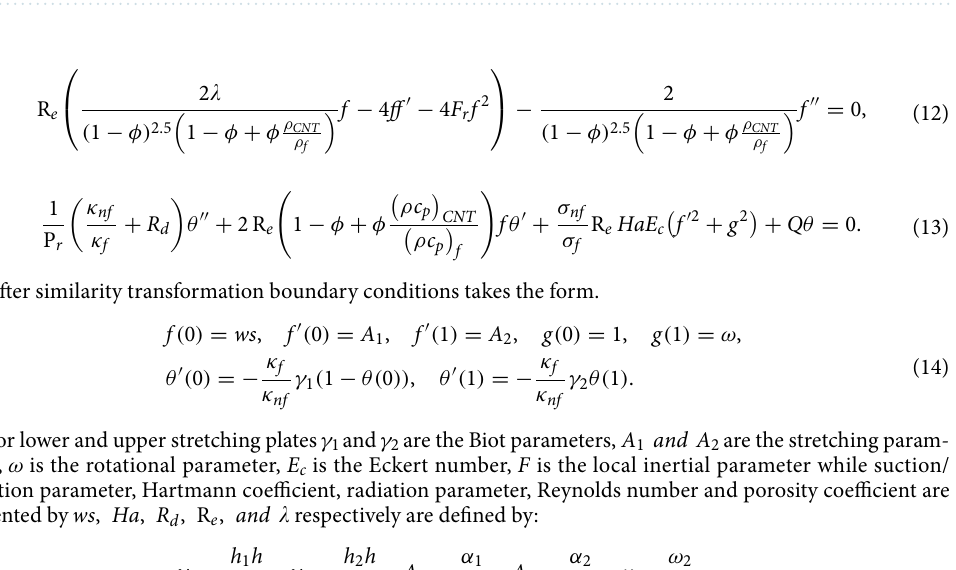
Table 1. Thermo-physical properties of H 2 O and CNTs 44,45